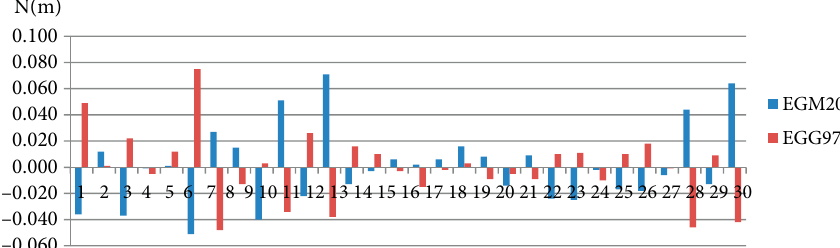
Fig. 3. Residual geoidal heights N over first order network points